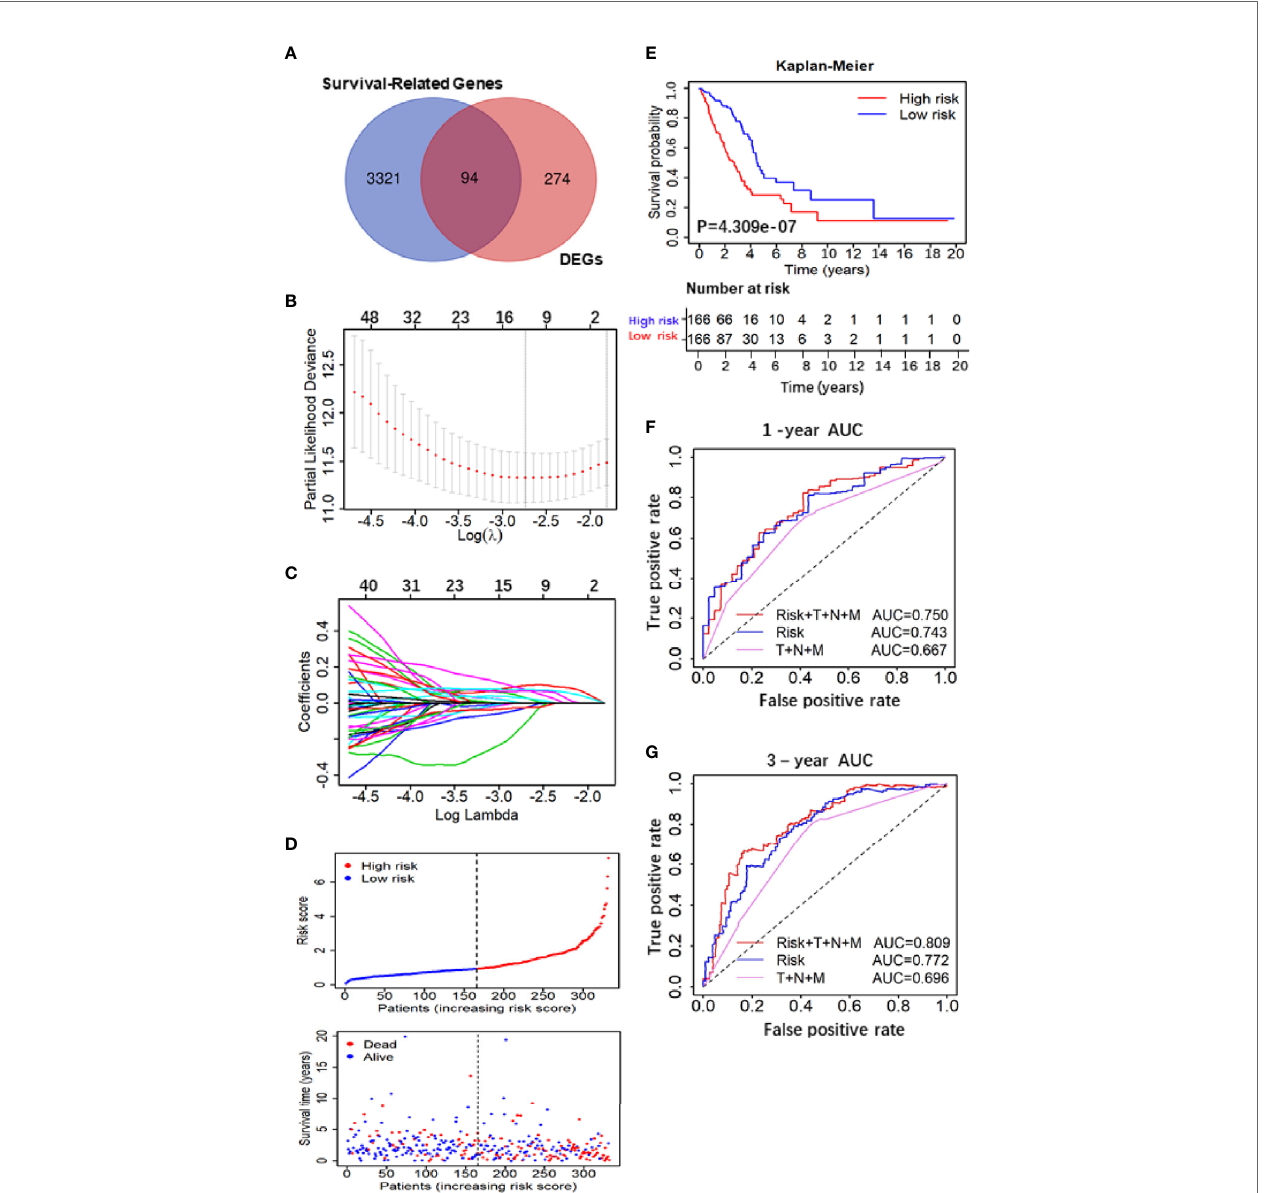
FIGURE 2 | Construction and assessment of the Five-Gene Prognostic Signature. (A) Venn diagram depicting potential prognostic gene of the inter section between DEGs and Survival-Related Genes; (B) A coef fi cient pro fi le plot was generated against the log (lambda) sequence. Selection of the optimal parameter (lambda) in the LASSO model. (C) LASSO coef fi cient pro fi les of the nine candidates in TCGA training set. (D) Patients ’ survival status distribution by the risk score; patient survival status distribution of the low-risk group and the high-risk group; (E) Kaplan – Meier curves for the low- and high-RS groups; (F , G) the receiver operating characteristic (ROC) curve validation of prognostic value by the risk score of 1 and 3